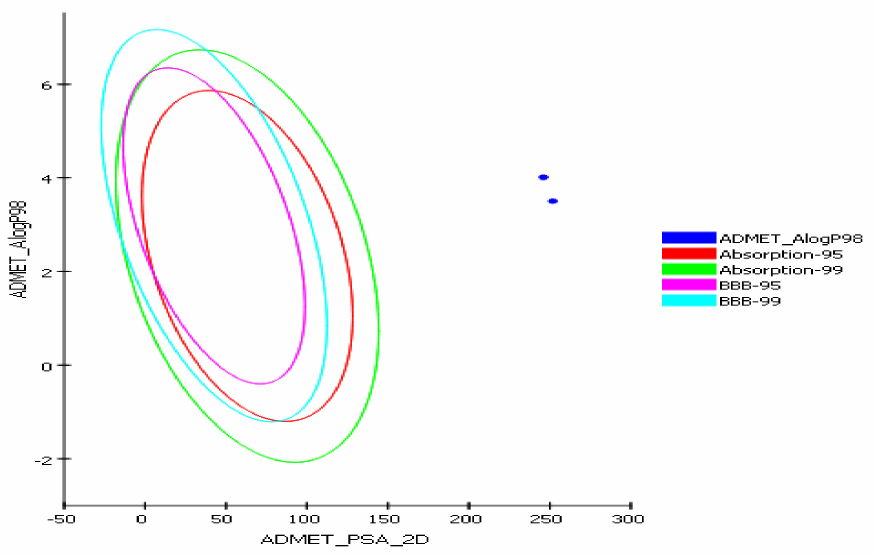
Figure 13. Blood − brain barrier (BBB) plot and human intestinal absorption (HIA) for 2a and 7 . BBB and human intestinal absorption (HIA) plots were determined for 2a and 7 .